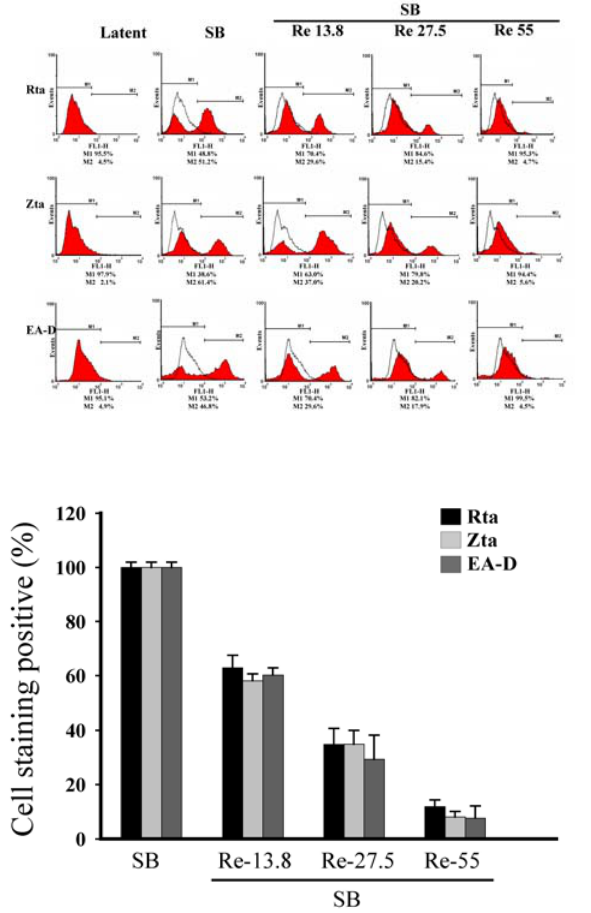
Figure 3. Inhibition of the expression of EBV lytic proteins by